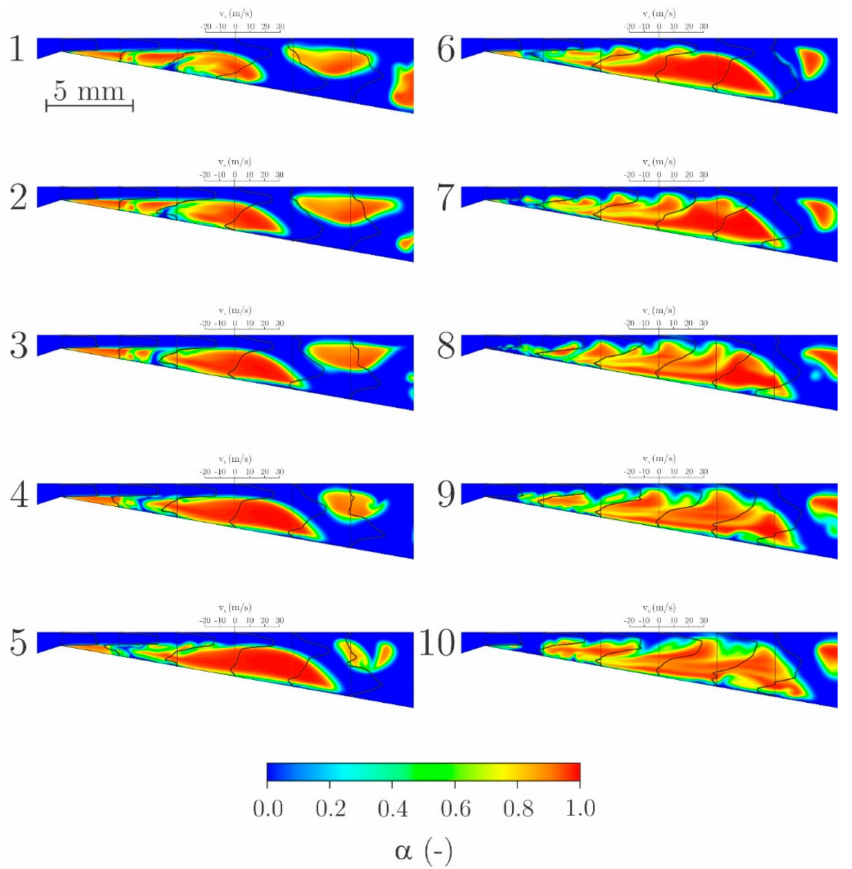
Figure 5. Development of Kelvin-Helmholtz instability with velocity profiles at individual cross- sections. The time difference between the images is ∆ t = 100 µ